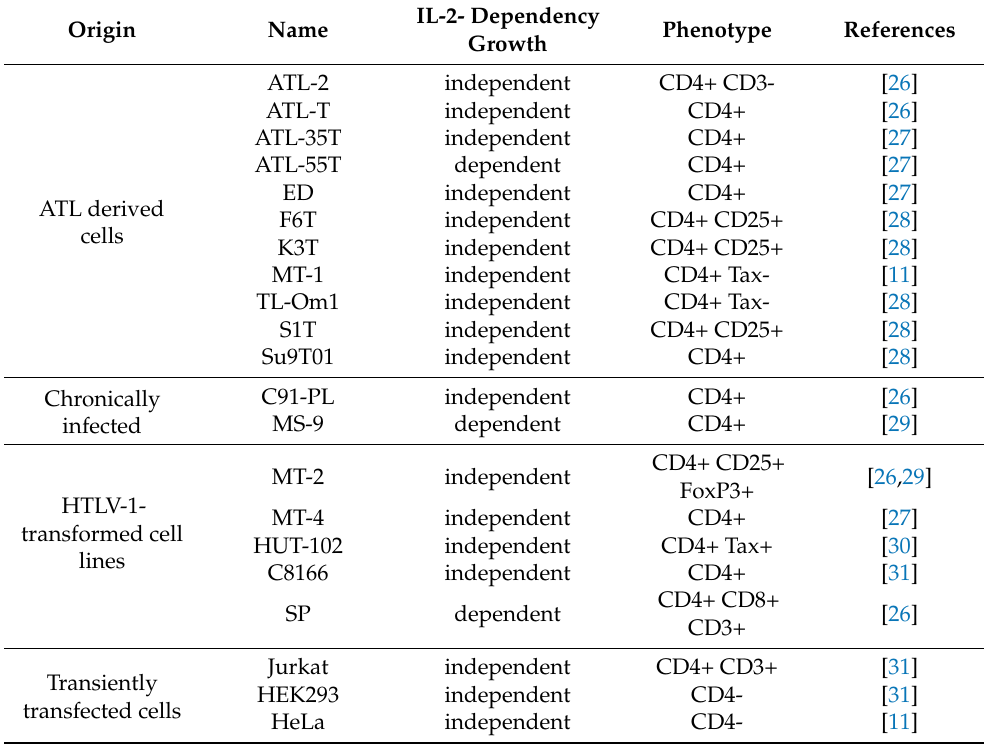
Table 1. Commonly used cell lines for studying